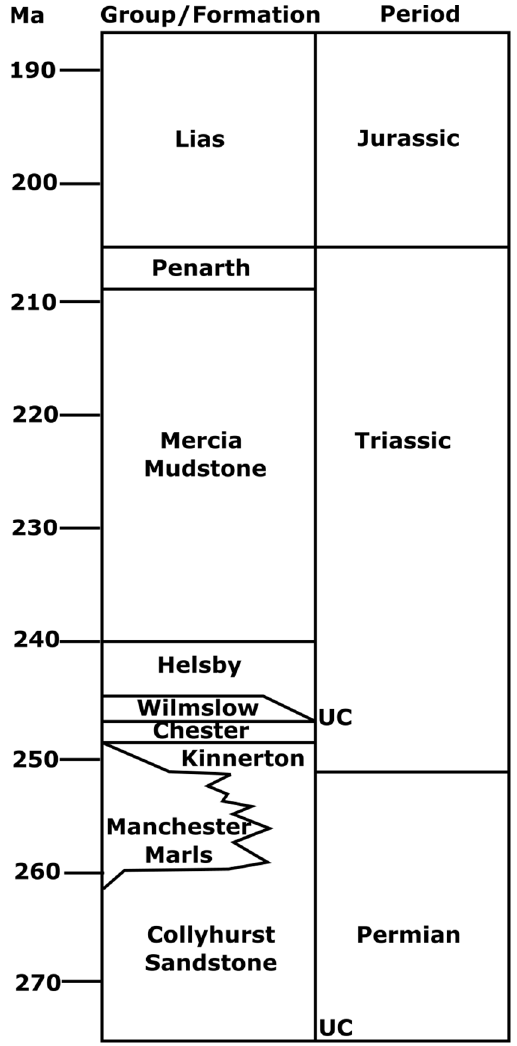
Figure 2. Stratigraphy of the basin fill. Developed from Plant et al. [23]. Note UC =